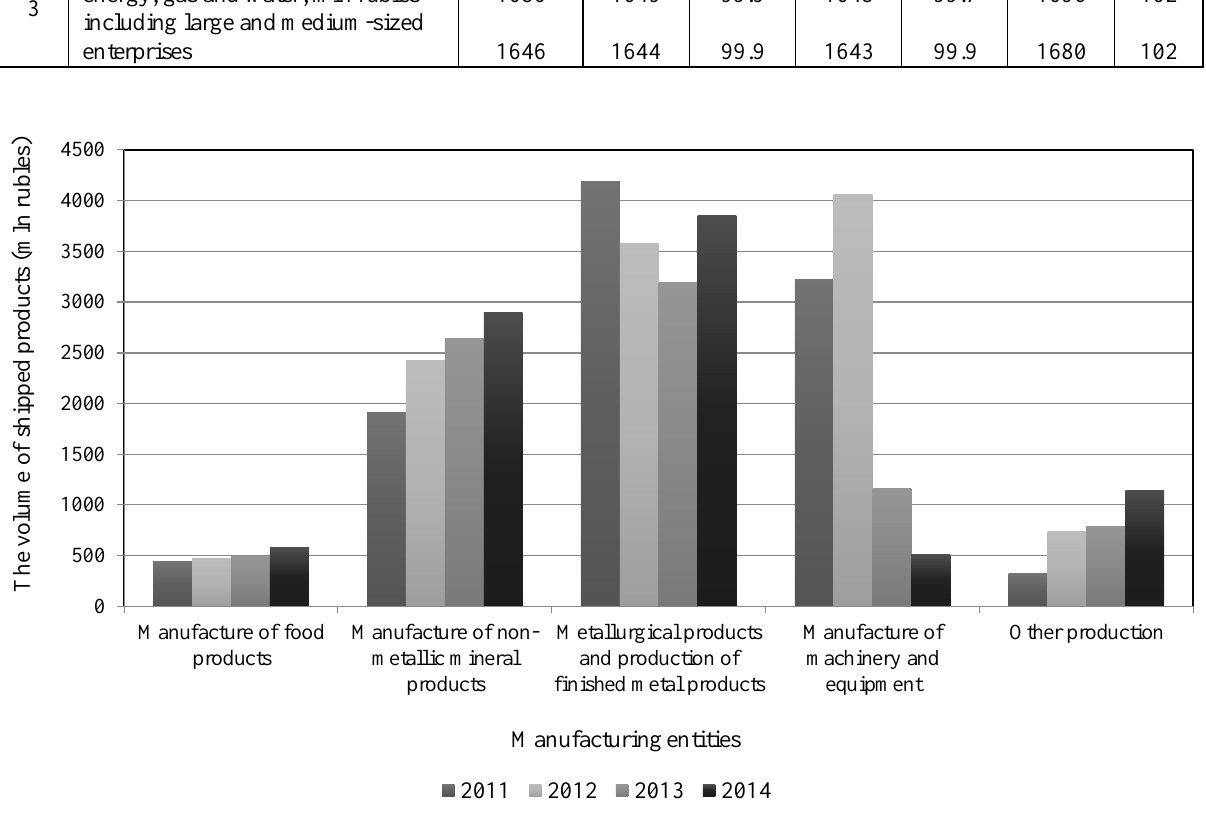
Fig. 1. Changes in the volume of shipped products to manufacturing entities for 2011–2014 (mln